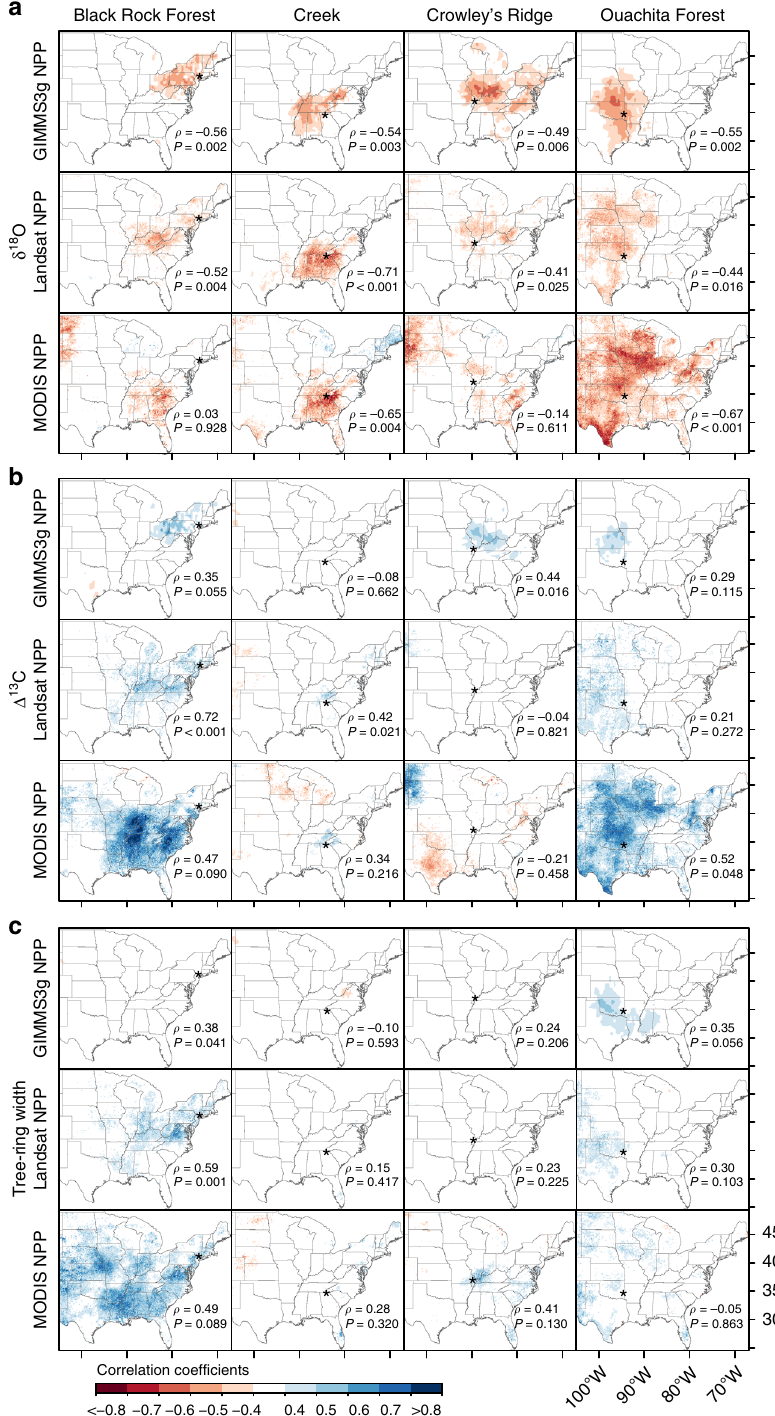
Fig. 2 Spatial fi eld correlations between tree-ring variables and satellite NPP products. Correlation coef fi cients were calculated between annually resolved tree-ring δ 18 O ( a ), Δ 13 C ( b ), and width ( c ) chronologies measured at four study sites and GIMMS3g NPP (1982 – 2011), Landsat NPP (1986 – 2015) and MODIS NPP (2001 – 2015) datasets. Study sites are represented by stars. Site-level correlations and their signi fi cance are indicated by Spearman ’ s rank correlation coef fi cient ( ρ ) and P -value ( P